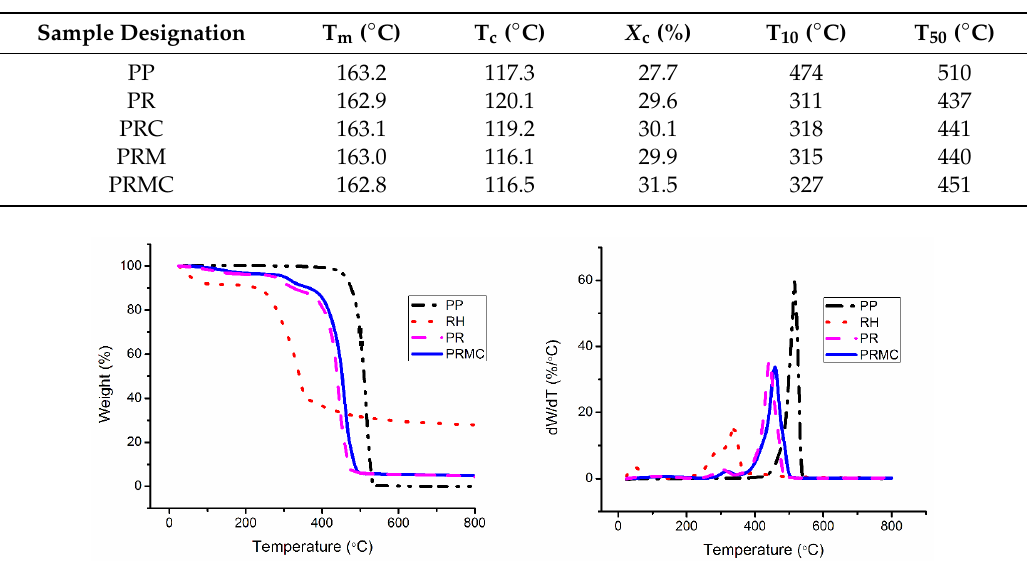
Figure 7. Thermogravimetry/derivative thermogravimetry (TG/DTG) curves for neat PP, RH, and the representative composites.